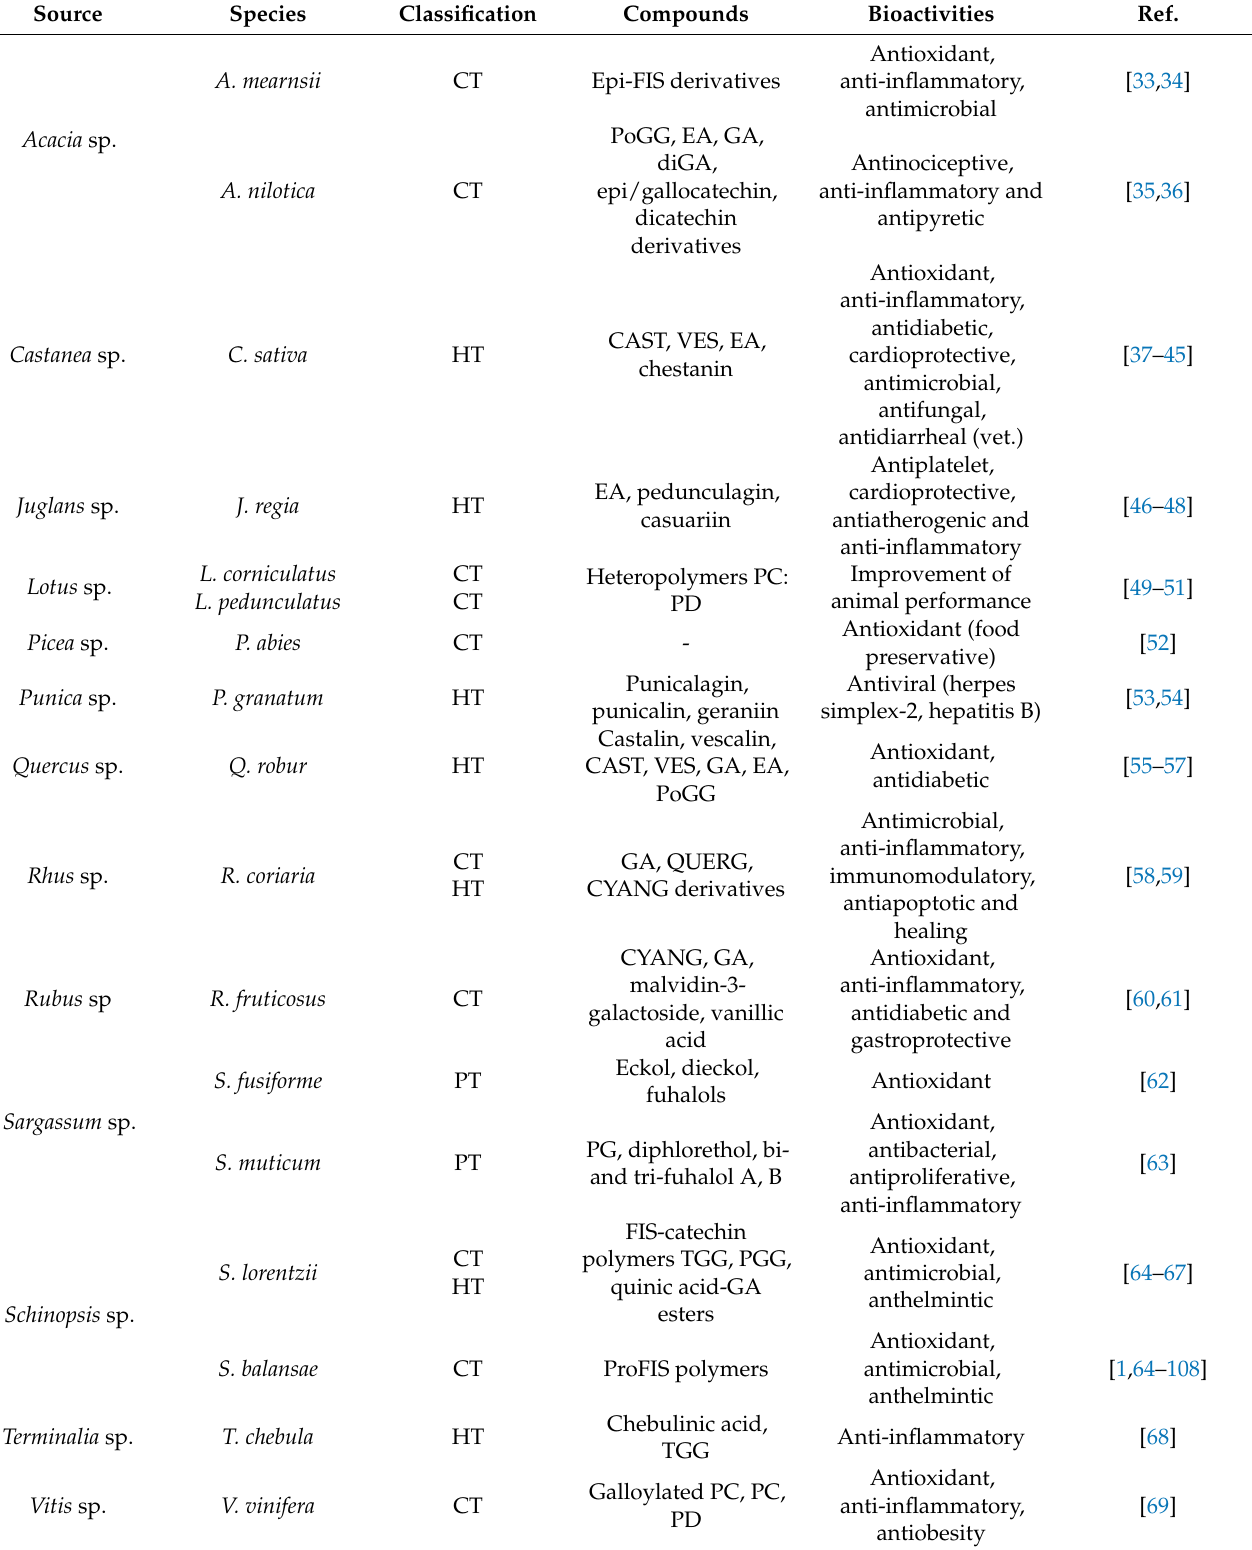
Table 2. Tannin-rich genera with some representatives and their tannin chemical profile, including major compounds and their reported